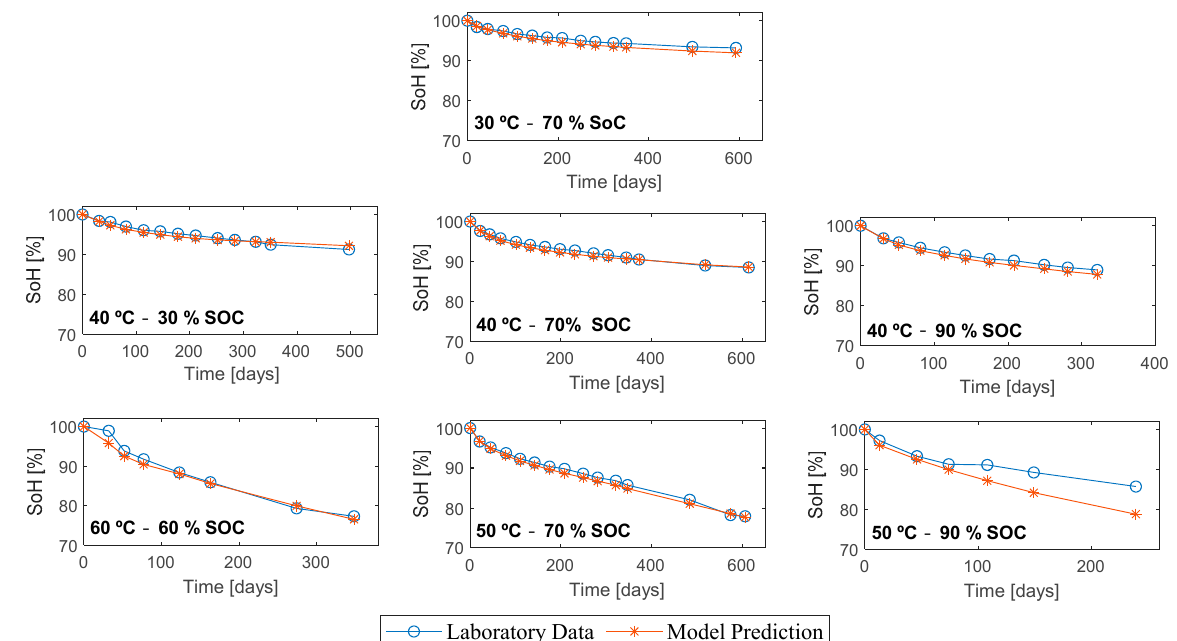
Figure 5. LFP laboratory data and LFP5 model prediction.